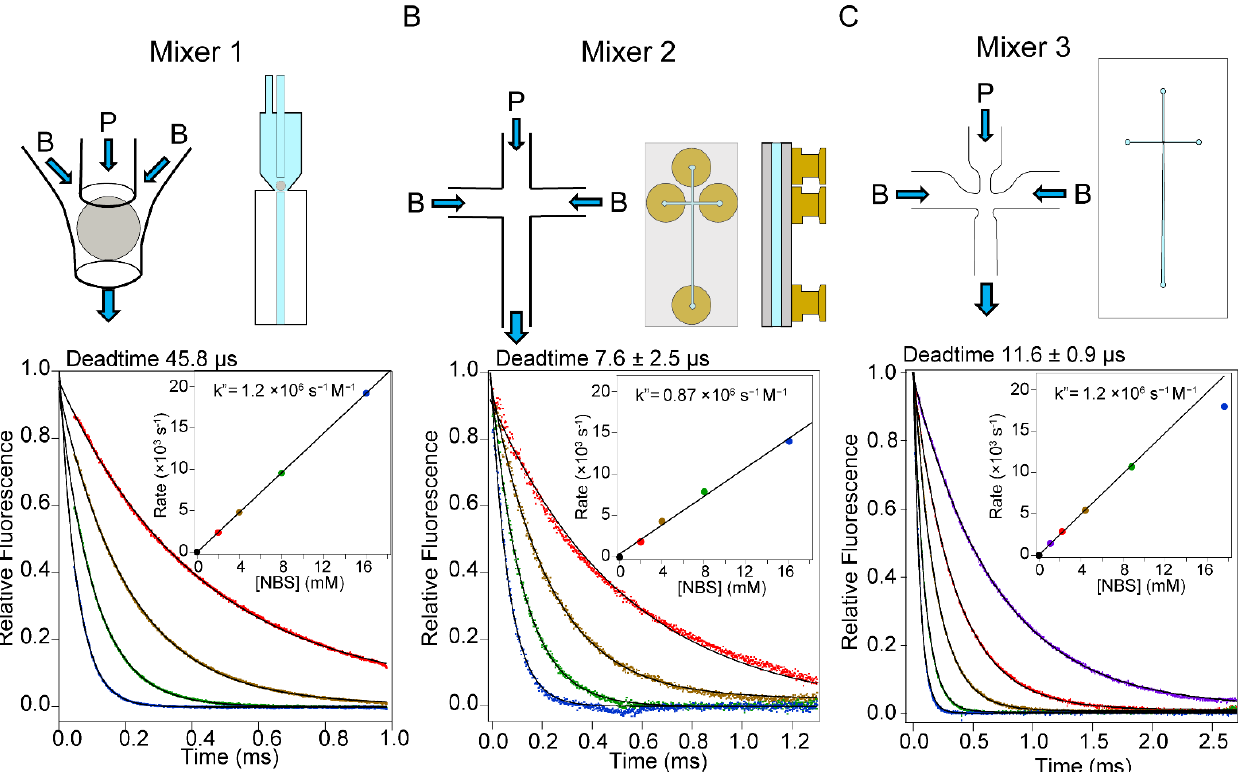
Figure 1. Summary of the mixer design and dead-time calibration of three continuous-flow mixing devices. Upper panels show schematics of the mixing regions and mixer/flow-cell assemblies for: ( A ) Mixer 1, the capillary mixer of Shastry et al. [8], ( B ) Mixer 2, a simple quartz cross-channel mixing chip (Translume, Inc., Ann Arbor, MI, USA) and ( C ) Mixer 3, a customized cross-channel mixing